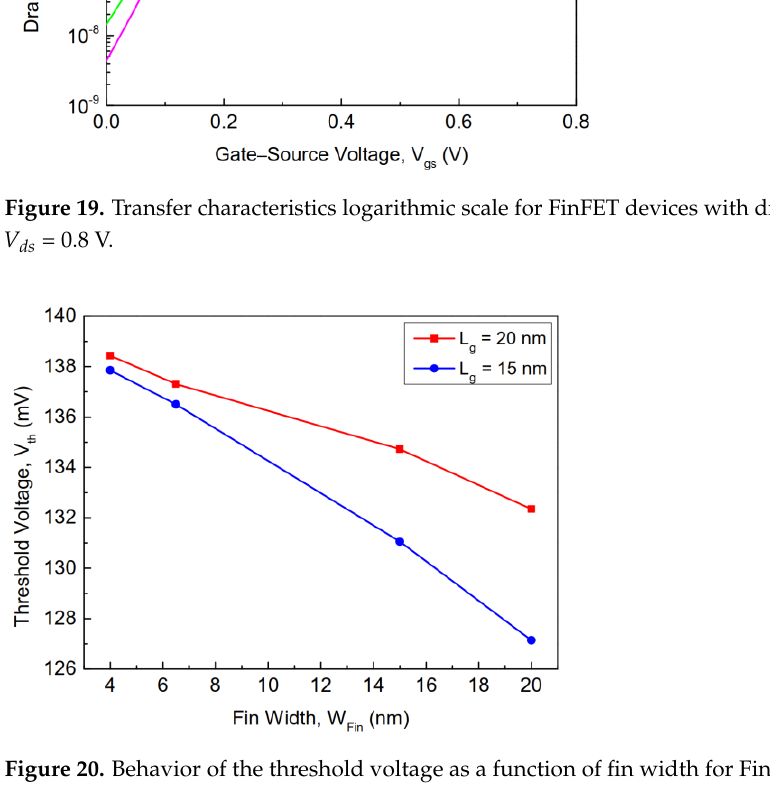
Figure 20. Behavior of the threshold voltage as a function of fin width for FinFET devices with two different gate lengths at V ds = 0.05 V.